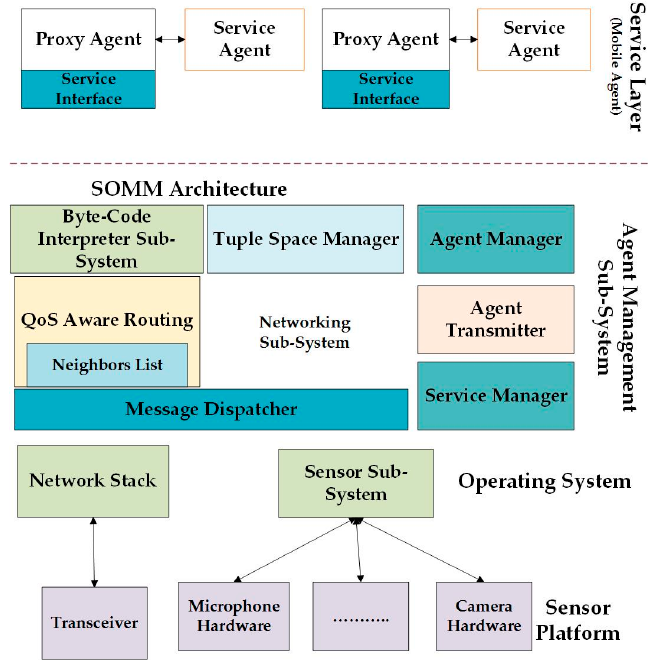
Figure 7. SOMM Architecture in the Server Node [51].